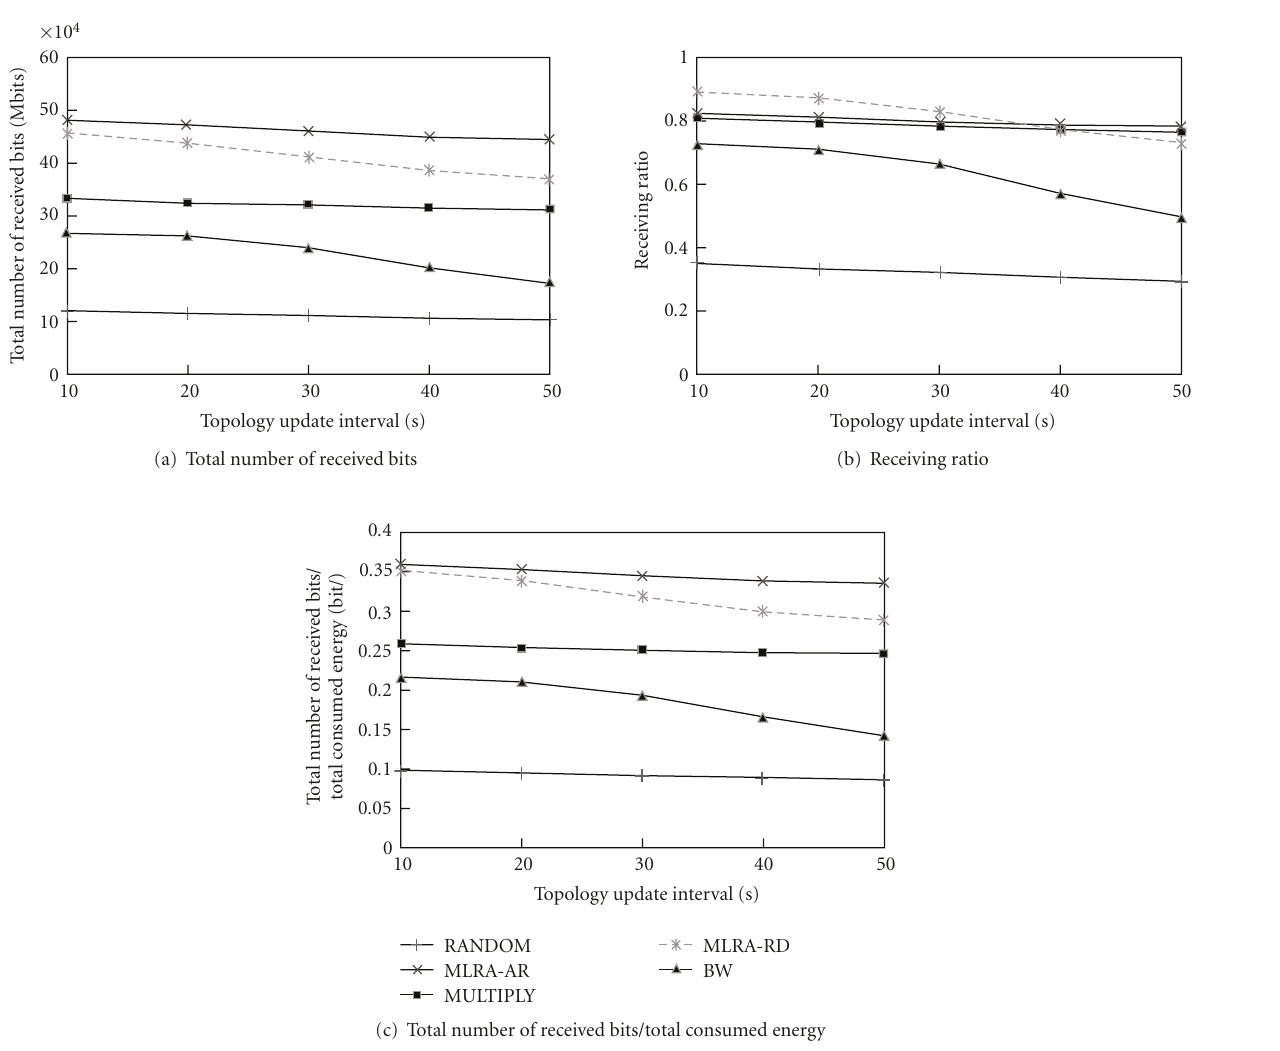
Figure 3: Performance versus topology update interval in tree topology with varying topology update interval. Other parameters are listed in Table